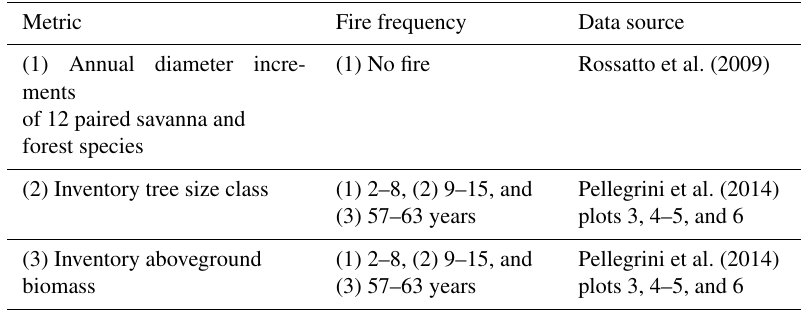
Table 1. Model evaluations at IBGE Ecological